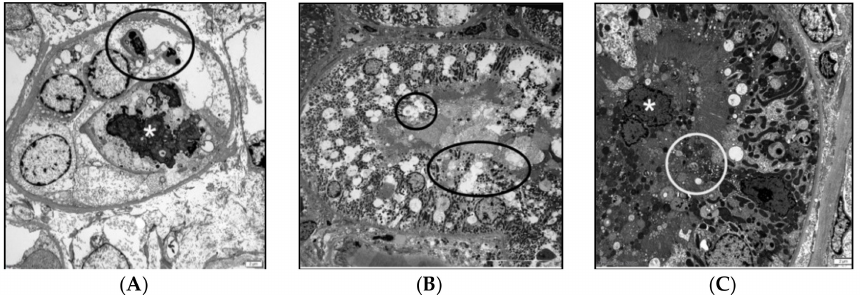
Figure 4. ( A ) Transmission electron micrograph from a control dog that had minimal acute tubular epithelial injury in the histology sample. The sample submitted for TEM showed sloughed cellular debris (circled) and electron dense cytoplasmic material (mineralization) (asterisk). There is denuded tubular basement membrane. Bar is 2 micron. ( B ) Transmission electron micrograph from a treated dog that had mild acute tubular epithelial injury in the histology sample. There is loss of the apical brush border of multiple cells (circled) whereas neighboring cells maintain intact brush borders. Bar is 20 micron. ( C ) Transmission electron micrograph from a control dog that had minimal injury in the histology sample. There is loss of the apical brush border (circled) as well as sloughed cells within the tubular lumen (asterisk). Bar is 2